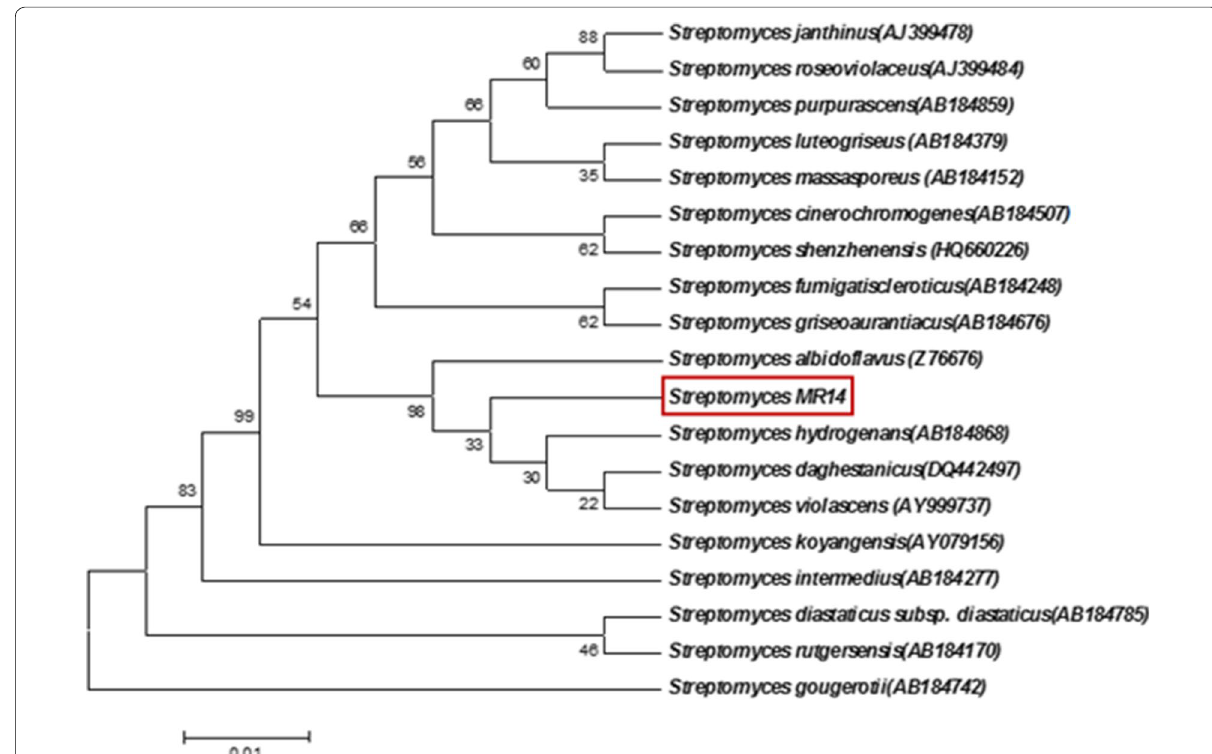
Fig. 3 Maximum-parsimony phylogenetic tree based on 16S rRNA gene sequences of Streptomyces strains showing the position of isolate Streptomyces sp. MR14. Bootstrap values (expressed as percentages of 1000 replications) are shown at the